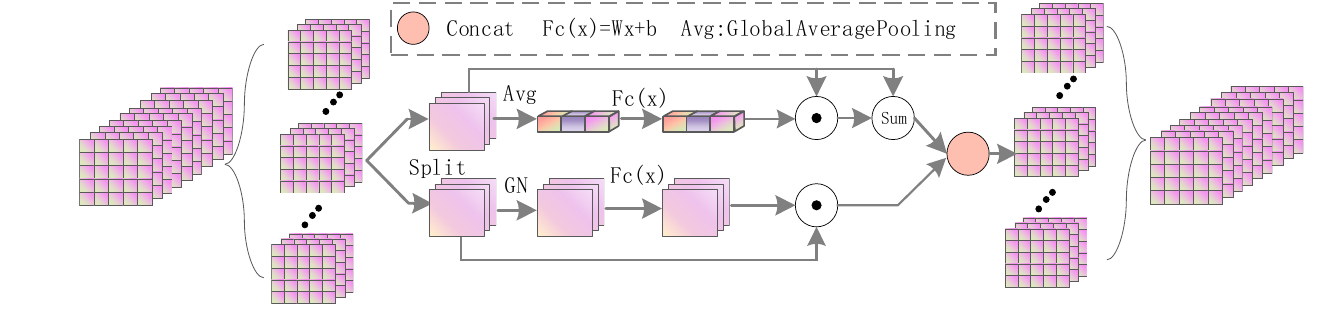
Figure 3. Structure of the self-attention module.